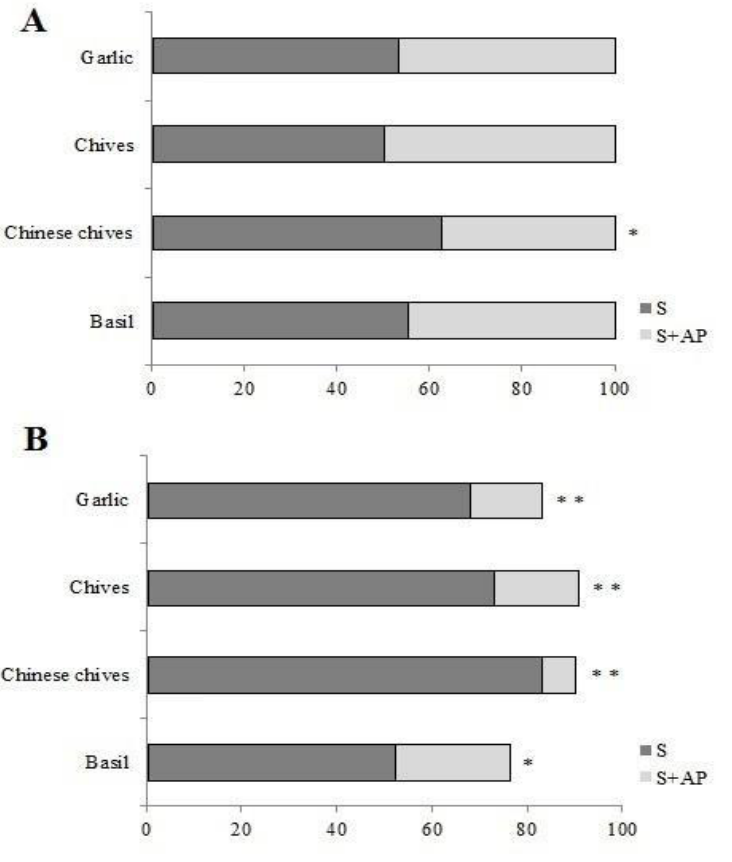
Figure 3. ( A ) Tetranychus urticae first choice response percentage on T-shaped arena test. (B ) T. urticae percentage response on the same test, 3 h after the test onset. S: in strawberry leaf; S + AP: Strawberry + Aromatic plant leaf. Bars followed by asterisk (* p < 0.05 or ** p < 0.01) denote significant differences based on Kruskal–Wallis and Student–Newman–Keuls (SNK) test statistics between strawberry × strawberry + AP leaves, in the same bar.